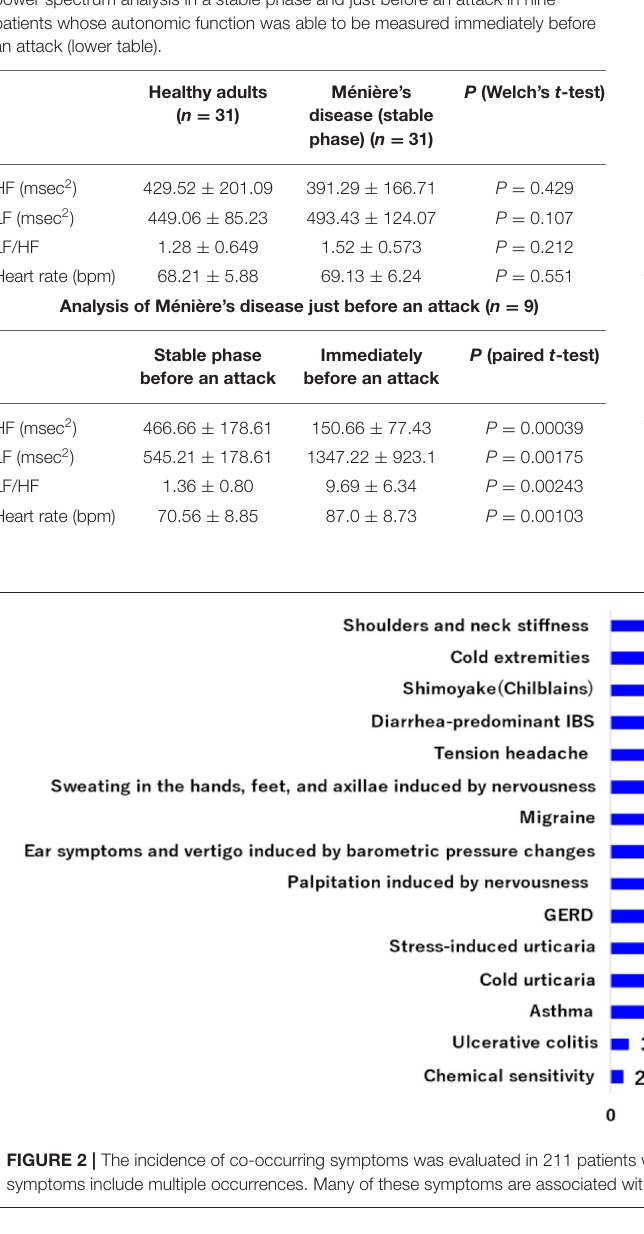
Frontiers in Neurology |